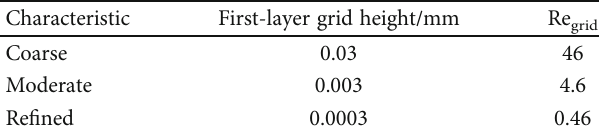
Table 3: First-layer grid height of the aircraft wall surface.